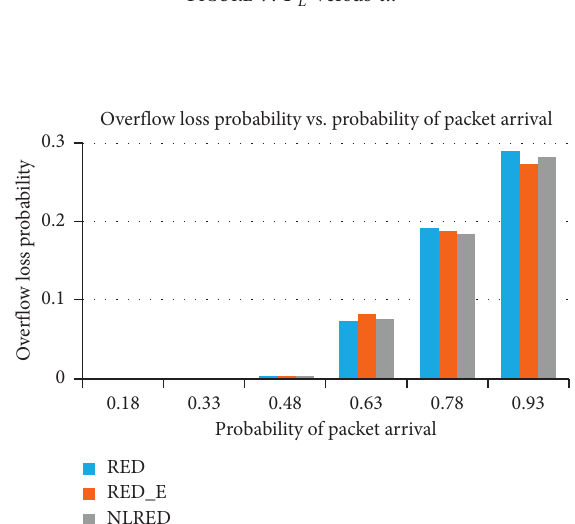
Figure 7: P L versus α .